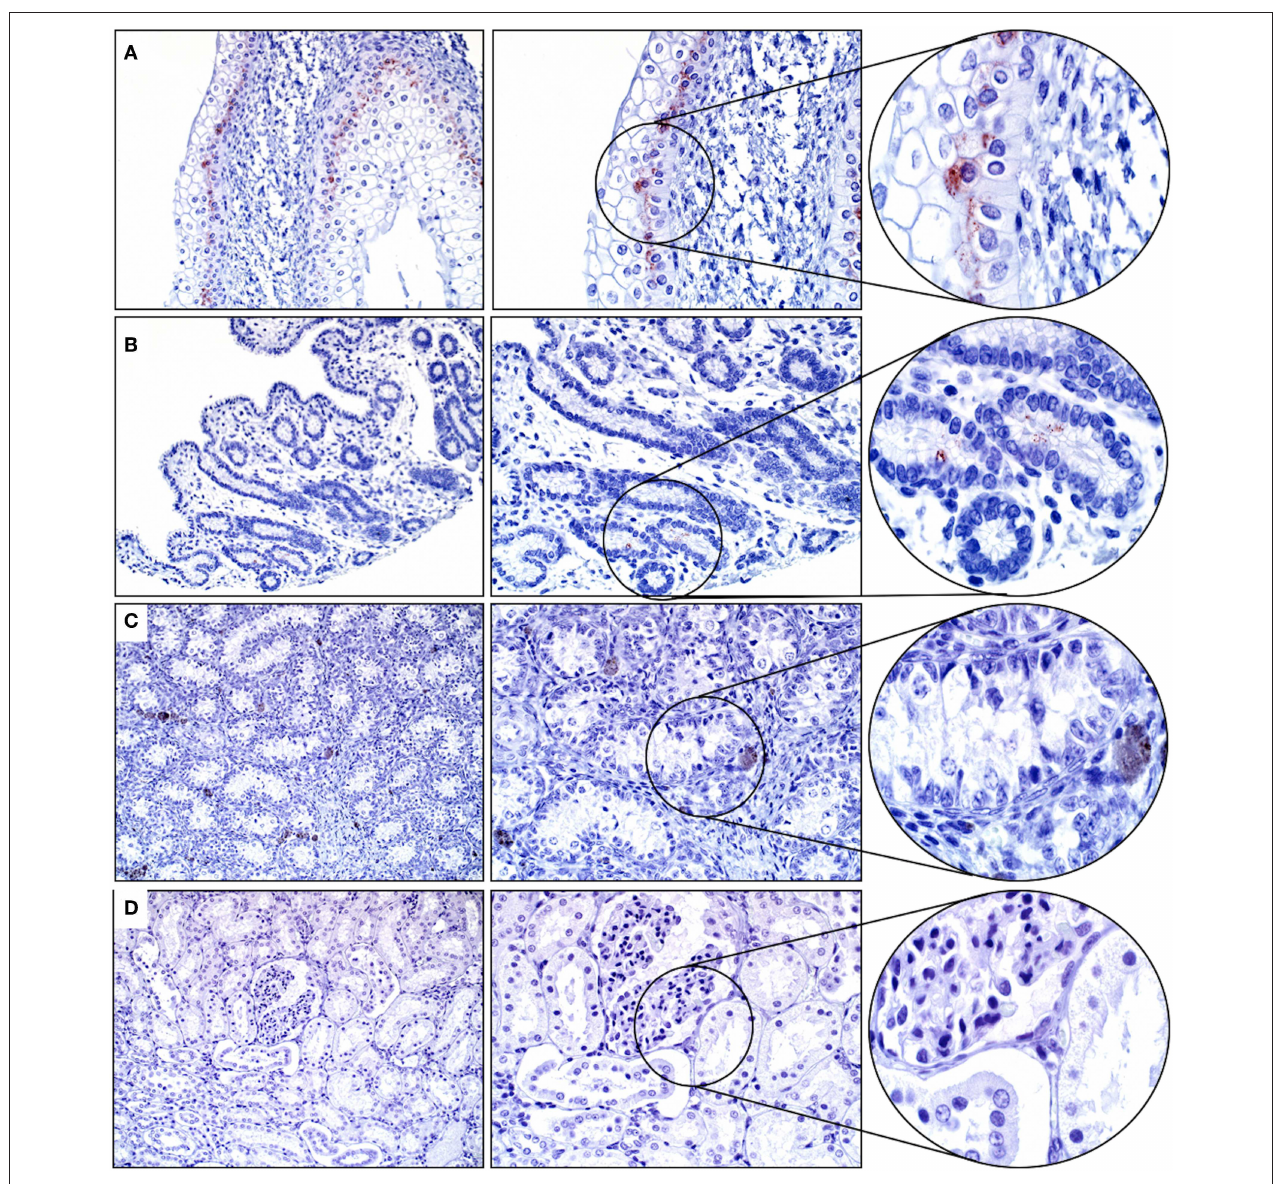
FIGURE 4 | Genitourinary tract. (A) There is moderate SALSA immunoreactivity in the basal epithelial layer of the urinary bladder mucosa. (B) Only rare single uterine gland epithelial cells are positive for SALSA. (C) Testis and (D) kidney are negative for SALSA. There are a few pigmented interstitial cells in the testis that are a normal finding in young horses. Magnification as in Figure 2